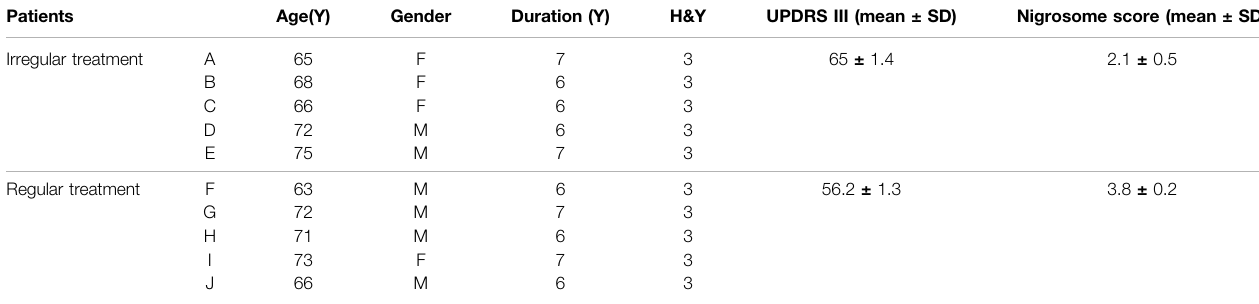
TABLE 3 | The information of patients with irregular and regular treatment.